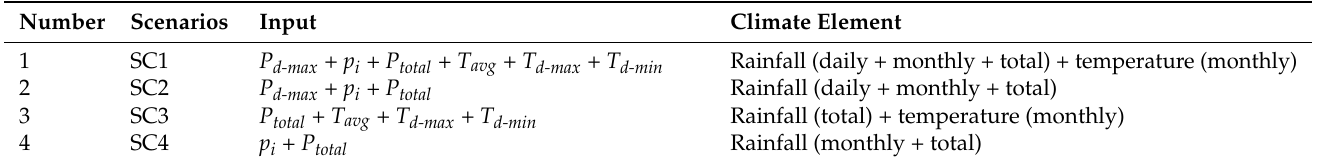
Table 5. Developed scenarios for MFI prediction based on ANN (MLP and RBF) in Central